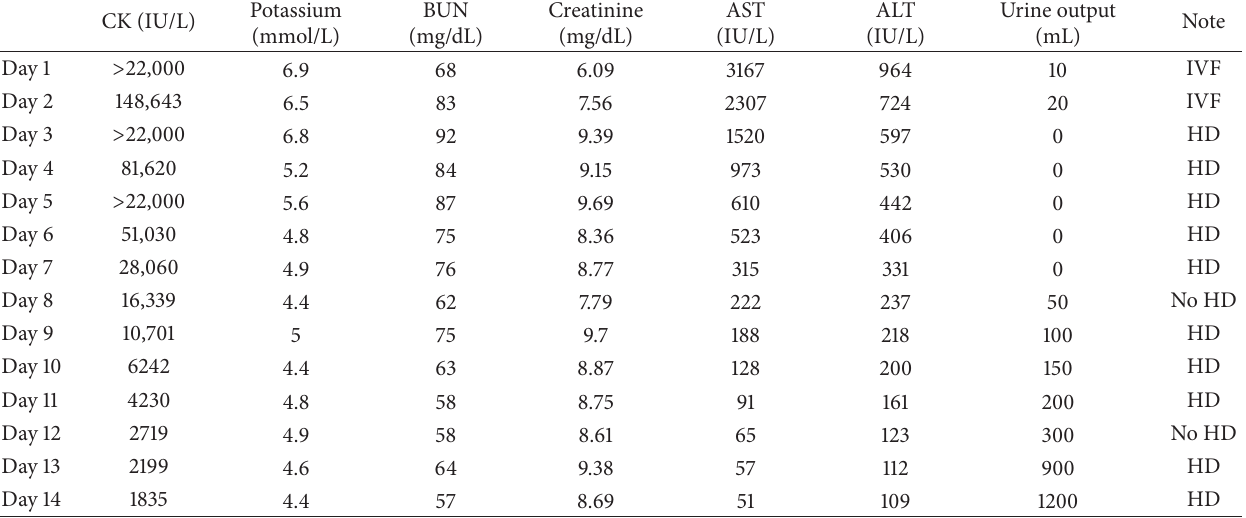
Table 1: Daily laboratory